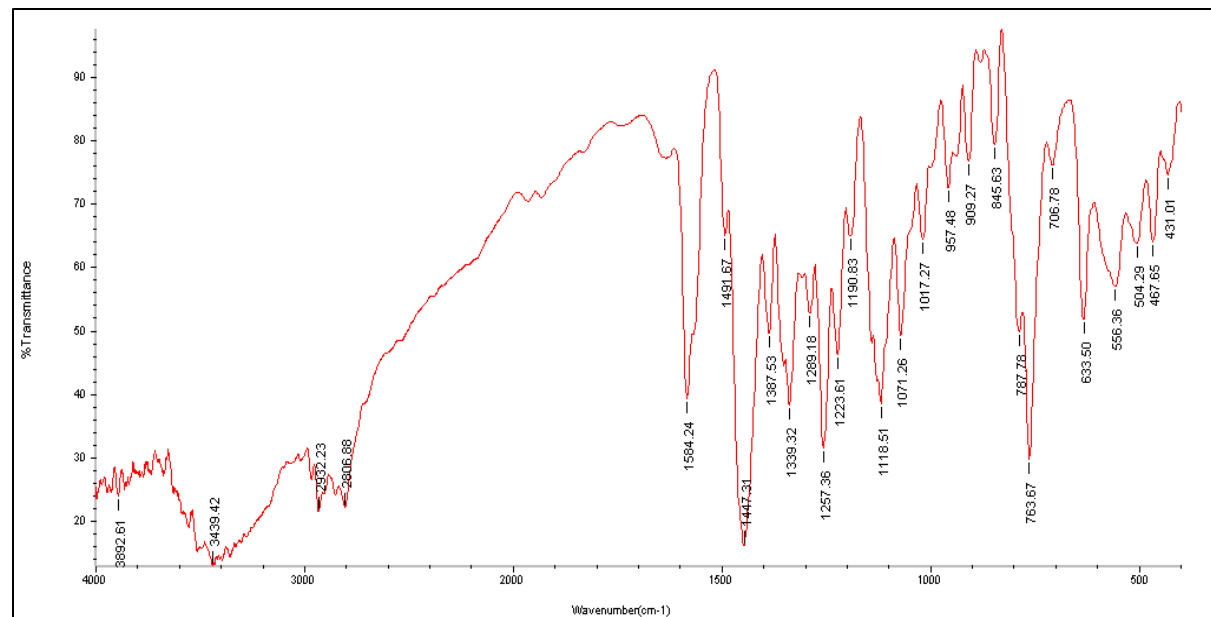
Figure 5.FT–IR spectra of mirtazapine pure